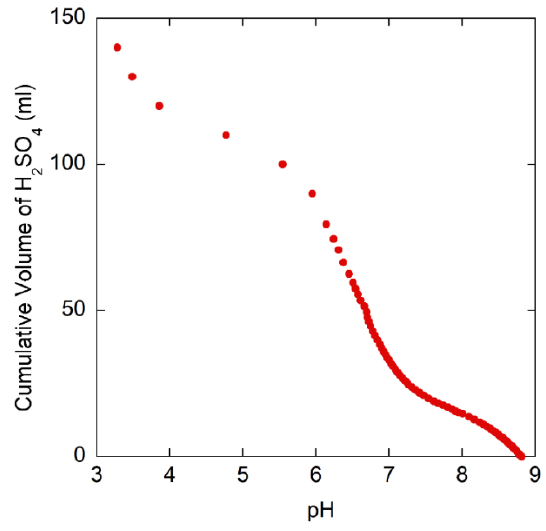
Figure 4. Change in pH with addition of 0.02N H 2 SO 4.